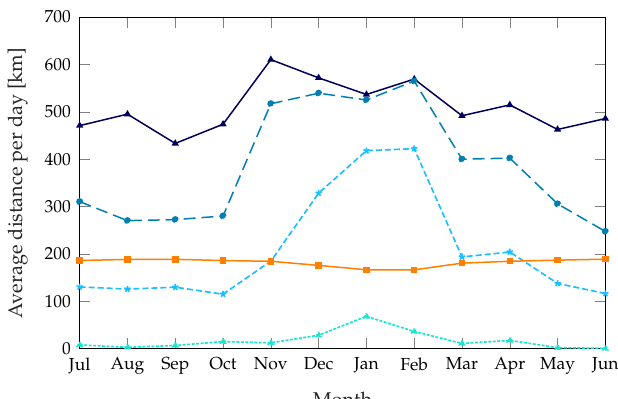
Figure 7. Average distance covered by rebalancing trucks per day, plotted over 12 months.